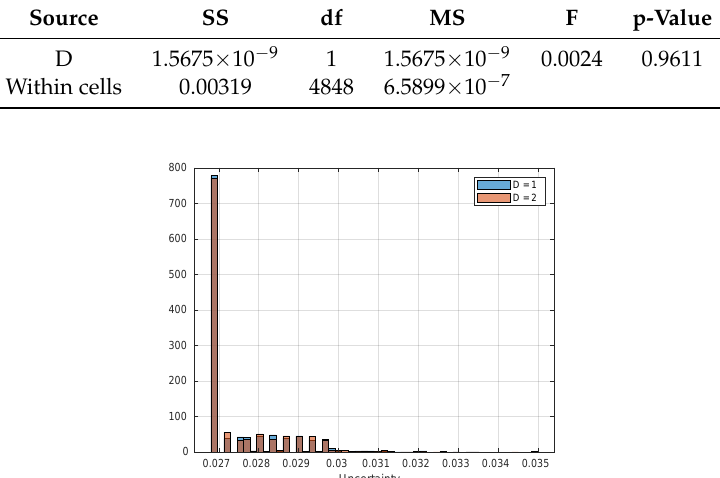
Figure A23. Histograms for the conclusion of the effect of factor D on the expected uncertainty performance when B = 2, represented for the two levels of factor